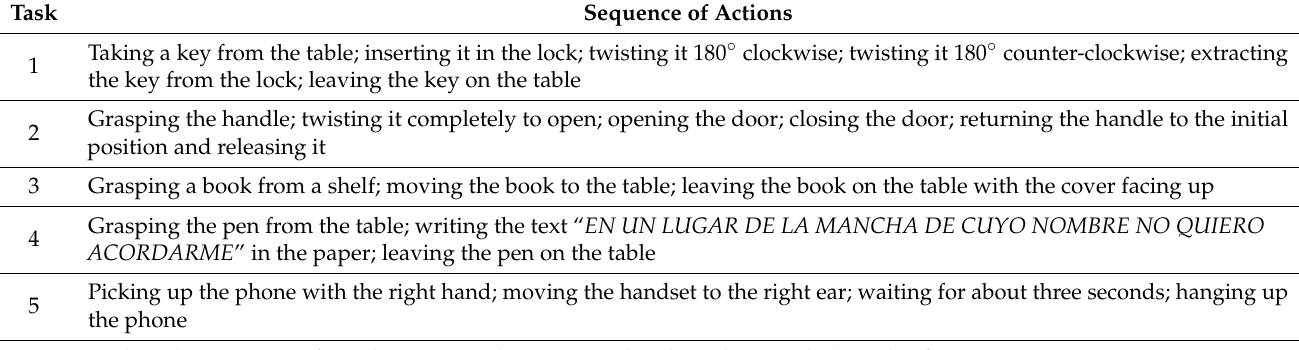
Table 2. Sequence of actions performed by the subject in each task. Task Sequence of